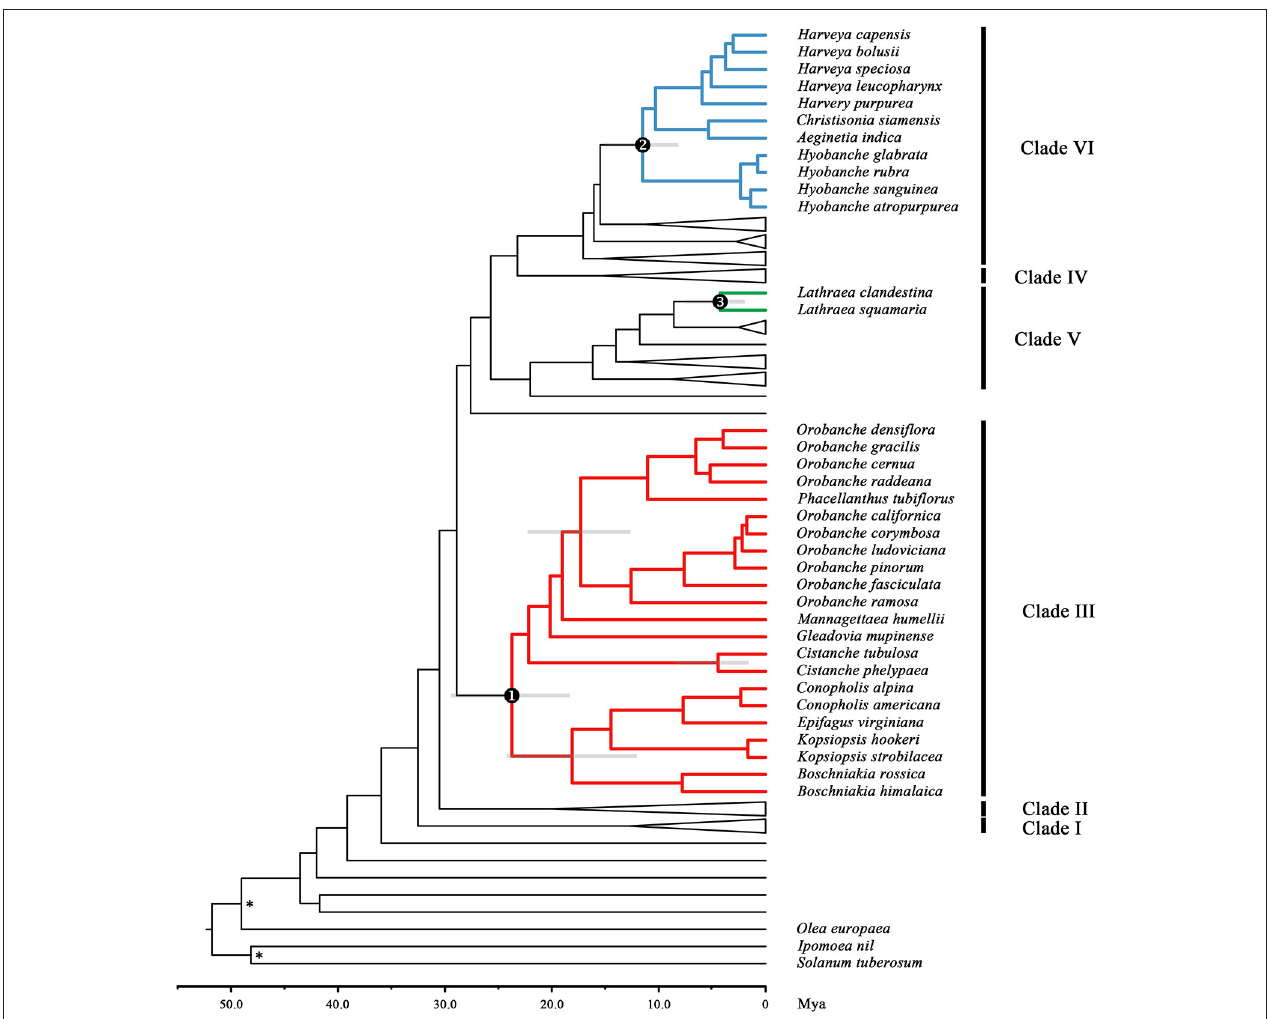
FIGURE 3 | The divergence times of the main clades in Orobanchaceae showing three non-synchronous origins of the holoparasitic clades. Topology of 134 species in Orobanchaceae and seven outgroup species, Paulownia tomentosa , Sesamum indicum , Scrophularia arguta , Antirrhinum majus , Olea europaea , Ipomoea nil, and Solanum tuberosum , obtained from a combined analysis of a 6,659 bp alignment of plastid and nuclear DNA sequence data. Calibration nodes are marked with an asterisk (*). Numbered circles and different colors mark the crown groups of the three holoparasitic clades in Orobanchaceae. The gray bars are the 95% HPD intervals for the divergence time estimates. Time in millions of years ago (Mya) is represented by the scale axis below the tree. Major clades referred to in the text are indicated: Clade I, Lindenbergia ; Clade II, Cymbarieae; Clade III, Orobancheae; Clade IV, Pedicularideae; Clade V, Rhinantheae (except Pterygiella nigrescens ), and Clade VI, Buchnereae. The expanded tree is presented in Figure S15